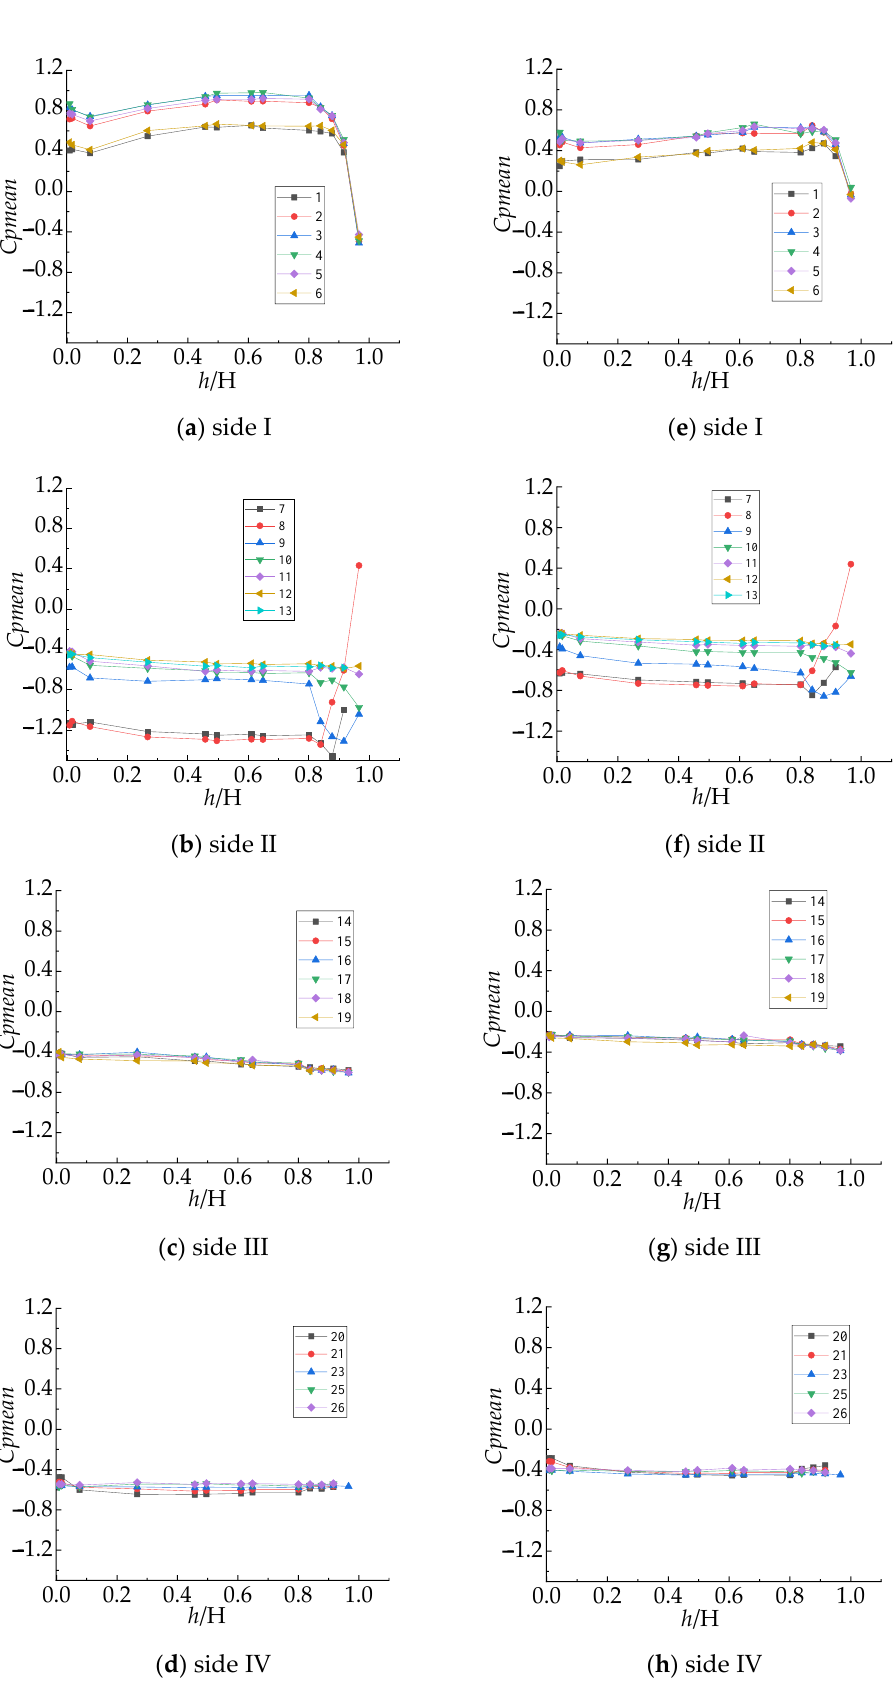
Figure 4. Variations in the average wind pressure coefficient Cpmean for building surfaces with increasing height. ( a – d ) Uniform flow (UF); ( e – h ) boundary layer (BL) ( φ = 90°, v = 10 m/s). (a) In Figure 4, comparing the average wind pressure coefficients Cpmean between the uniform flow and the boundary layer flow, the Cpmean value under the uniform flow field is generally slightly higher than that under the influence of the boundary layer flow, indicating that the effect of the regional wind environment in which the building is located cannot be ignored; (b) When focusing on the wind pressure coefficient of the building facades, it is found that the average wind pressure coefficients for the windward area (side I) show positive values (except the top point at layer N), and the highest measurements are found in the upper-middle part of building and gradually decrease along both sides. The average wind pressure coefficients of the measuring points for lines 1 and 6 are significantly lower than those for the middle measuring points (lines 2 – 5), both in the uniform flow and the boundary layer flow. The measuring points on the top floor of the building reflect negative pressures, indicating that the roof airflow is separated and that vortexes might occur; (c) The measurement values for sides II – IV are determined by negative pressure and the values are evenly distributed with the increasing height without significant differences. However, influenced by the concave and convex shape of the building, lines 7 and 8 contribute the maximum negative wind pressure on the building surface, while the values of lines 25 and 26 at the symmetrical position are more moderate. 3.1.2. Distribution of Mean Wind Pressure Coefficient in the Horizontal Planes Representative horizontal layers of measurement points were selected (layers A, D, E, H, L, and N) (see Figure 5). Due to the symmetrical nature of the building, only the